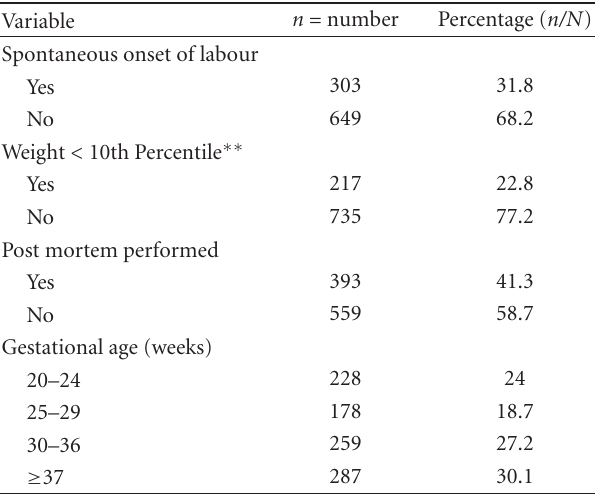
Table 1: Demographic details of stillborn